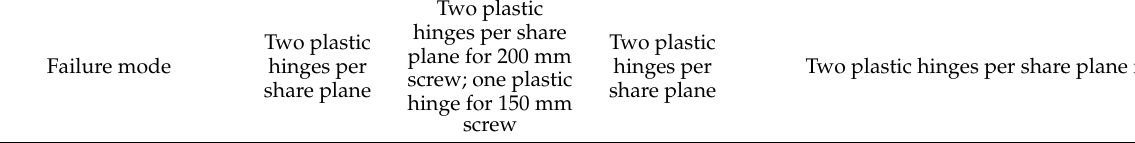
Figure 30. Comparison between the experimental and theoretical results in terms of capacity *. * Note: S-W-R = Connection -B with HBS screw, S-W-S = Connection -B with SDWS, A-C = Apex connection, S-P-R-Euro = Connection -A with HBS screw prediction using Eurocode 5, S-P-S-Euro = Connection -A with SDWS screw prediction using Eurocode 5, S-P-R-CSA = Connection -A with HBS screw prediction using CSA 086-19, S-P-S-CSA = Connection -A with SDWS screw prediction using CSA 086-19.